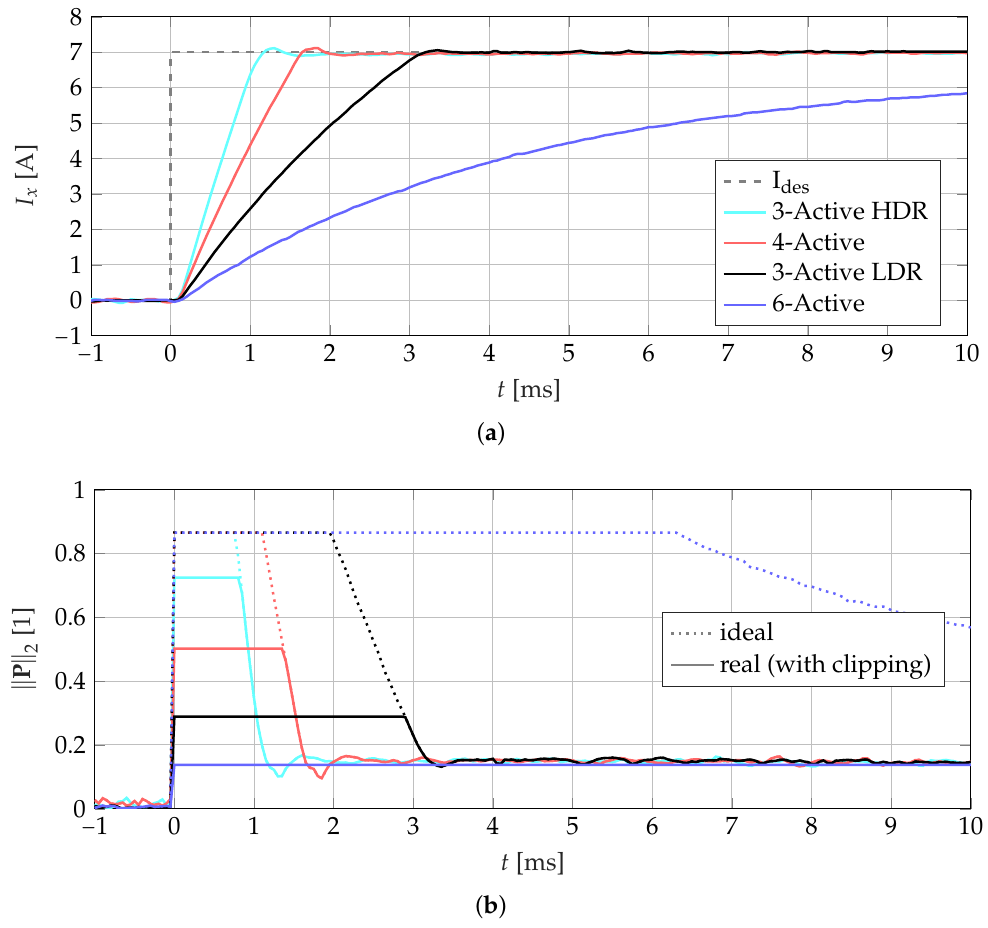
Figure 16. ( a ) Step response of the current controller for different SVMs. ( b ) Corresponding magnitude of the desired voltage space vector P ( f PWM = 20 kHz, U DC = 12 V, t inf =